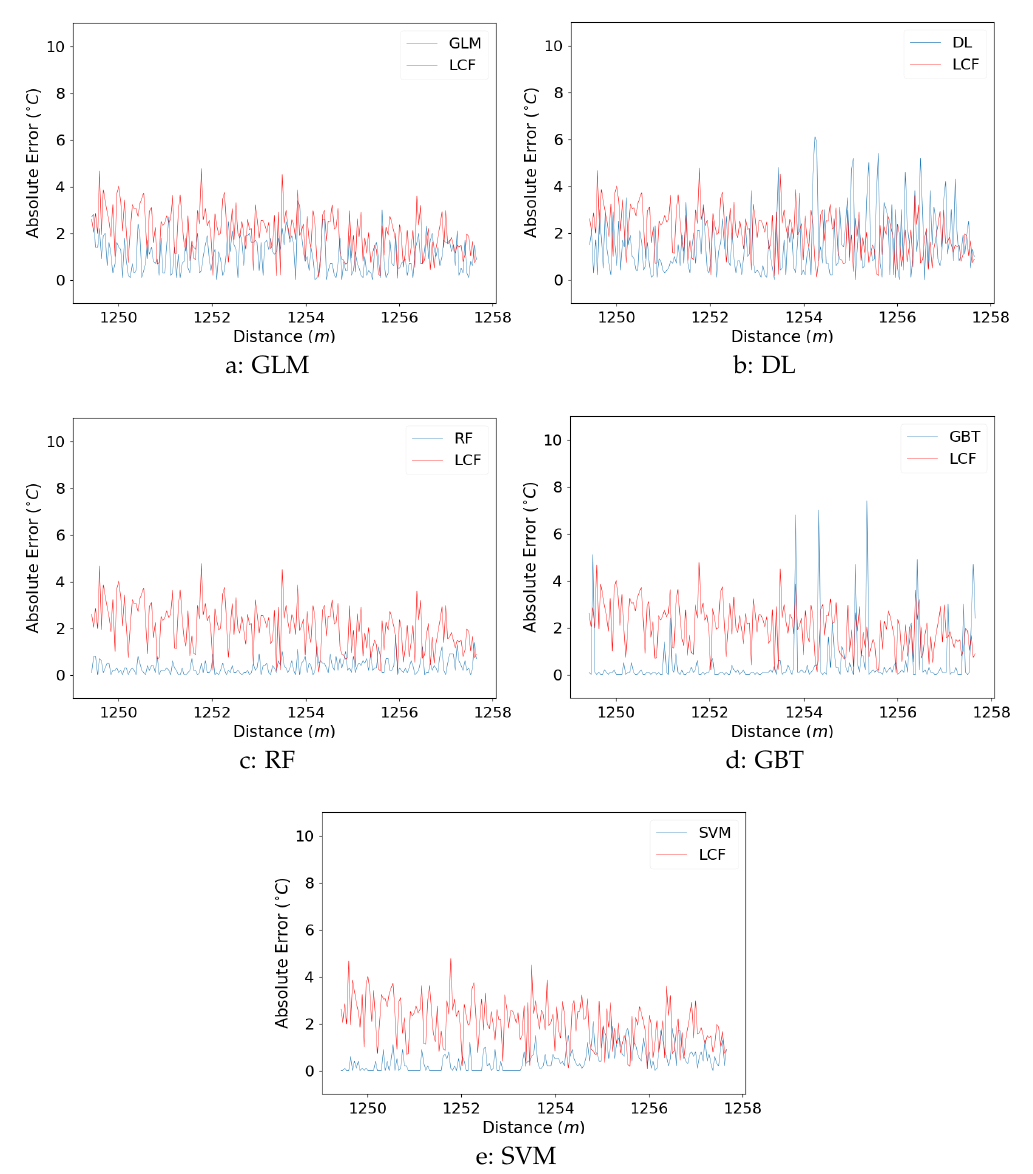
Figure 6. Absolute error at heated location (65 ◦ C